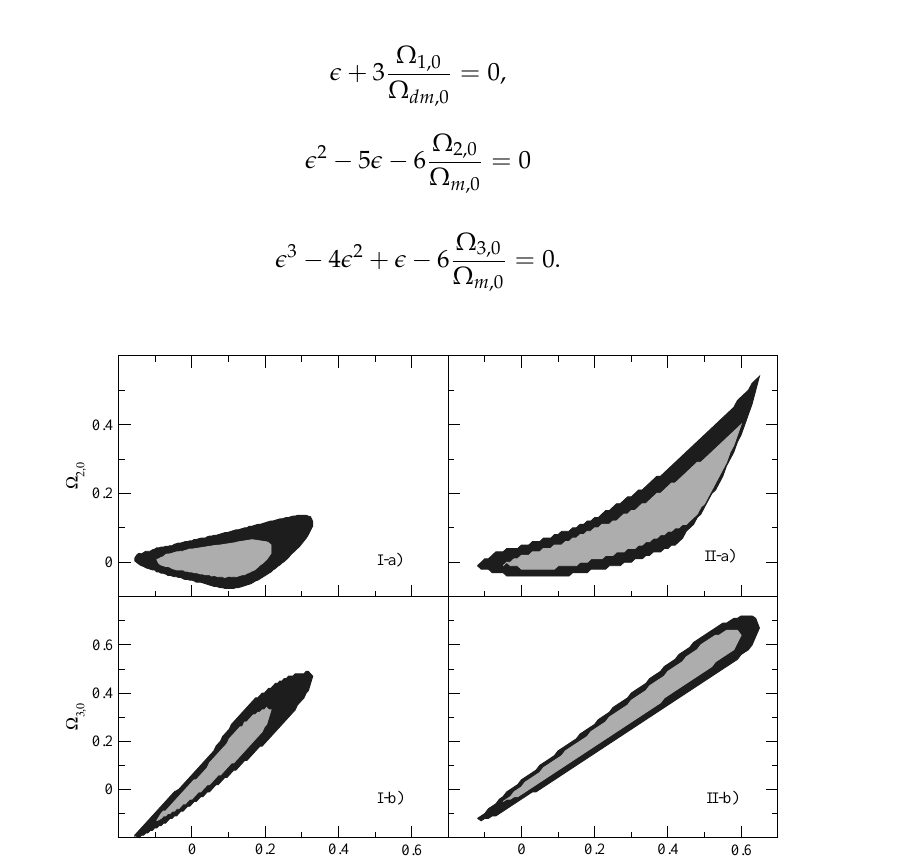
Figure 1. The Ω 1,0 − Ω 2,0 ( top ) and Ω 1,0 − Ω 3,0 ( bottom ) parametric spaces from Approaches I and II. The contours are drawn for ∆ χ 2 = 2.30 and